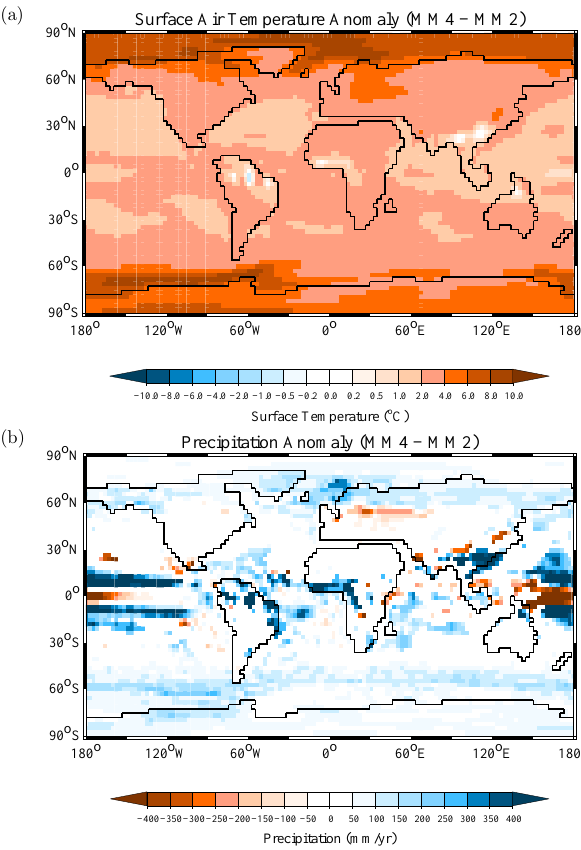
Fig. 16. (a) Annual mean surface temperature and (b) precipitation anomalies between experiments MM4 and